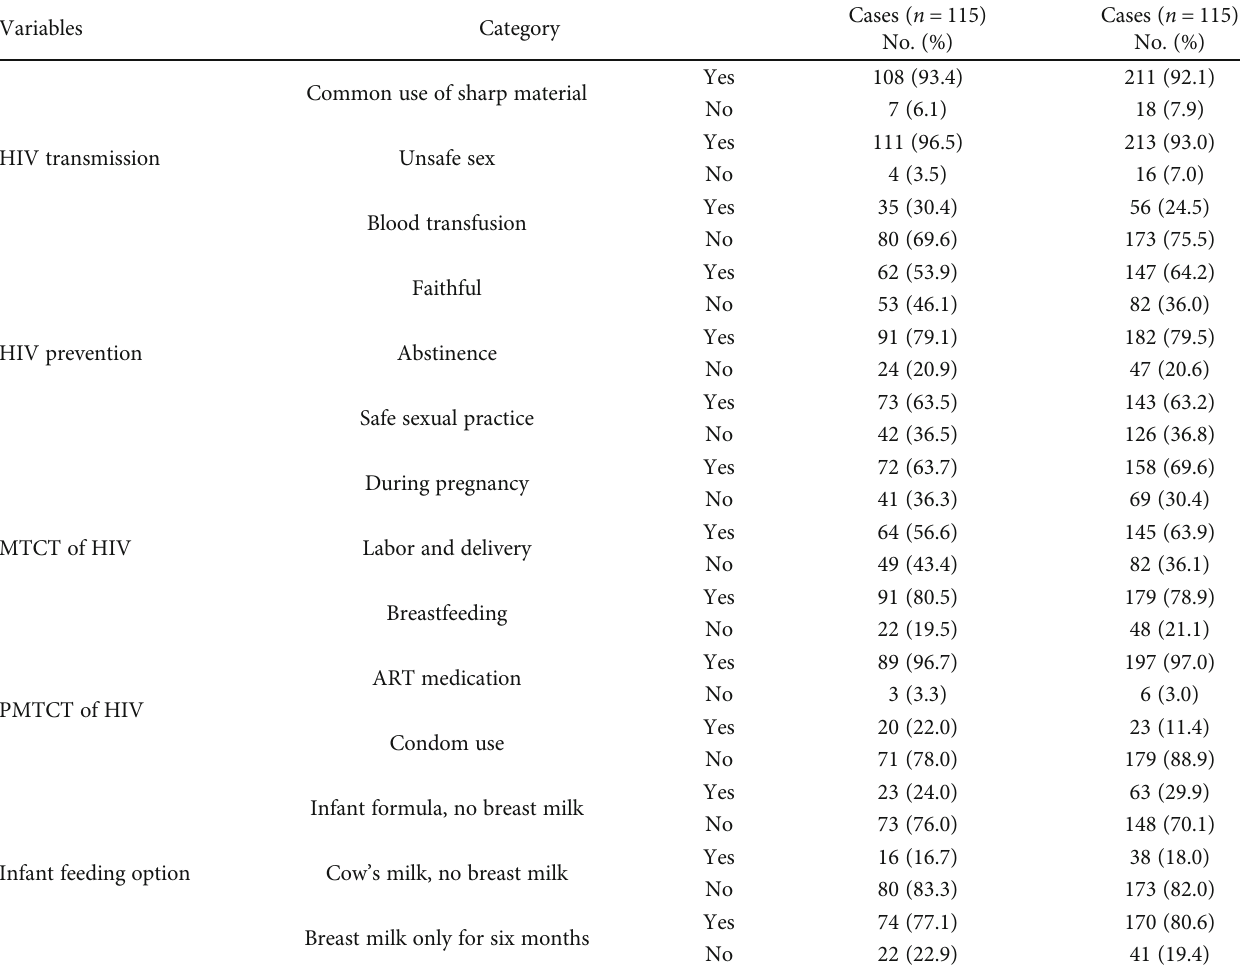
Table 3: Assessments of HIV pregnancy-related knowledge among women living with HIV attending ART at Jimma University Medical Center, 2019 ( N = 344